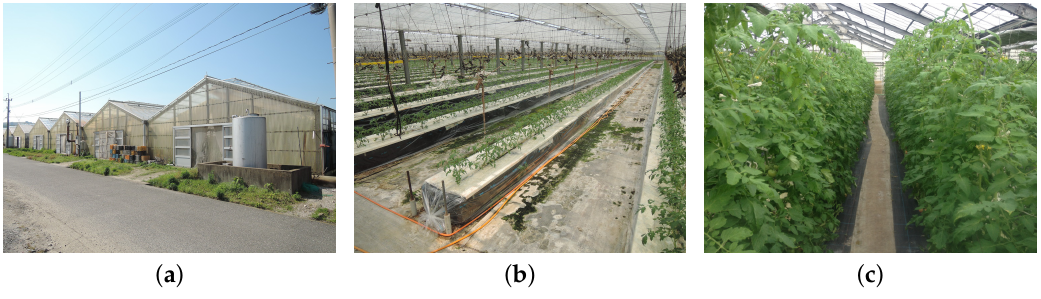
Figure 1. Experimental Field. ( a ) Outside greenhouse; ( b ) inside greenhouse just after planting tomato seedlings; ( c ) inside greenhouse.